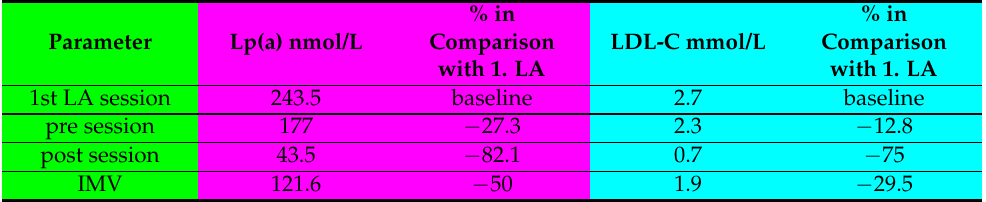
Table 1. Comparison of Lp(a) and LDL-C concentrations measured before (pre), after (post) and IMV at an LA session in 2019 with the initial Lp(a) and LDL-C levels before the 1st LA session. % in % in Parameter Lp(a) nmol/L Comparison LDL-C mmol/L Comparison with 1. LA with 1. LA 1st LA session 243.5 baseline 2.7 baseline pre session 177 − 27.3 2.3 − 12.8 post session 43.5 − 82.1 0.7 − 75 IMV 121.6 − 50 1.9 −